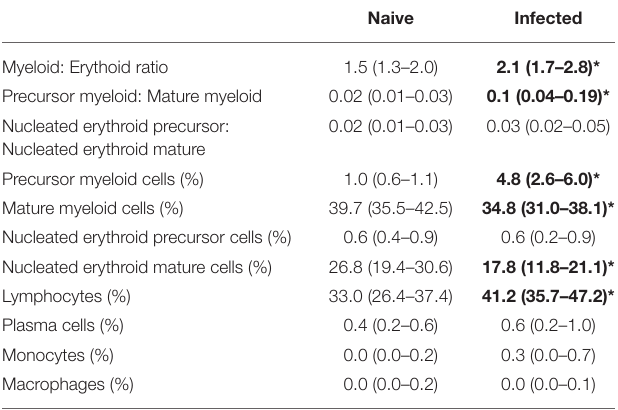
TABLE 2 | Comparative myelogram of naïve mice and mice infected with L. donovani for 28 days.